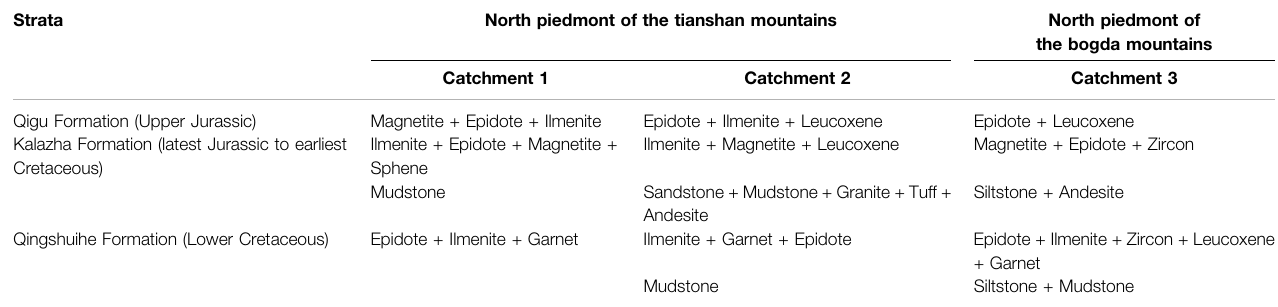
TABLE 4 | Heavy mineral assemblages and conglomerate components of the late Mesozoic Southern Junggar Basin.